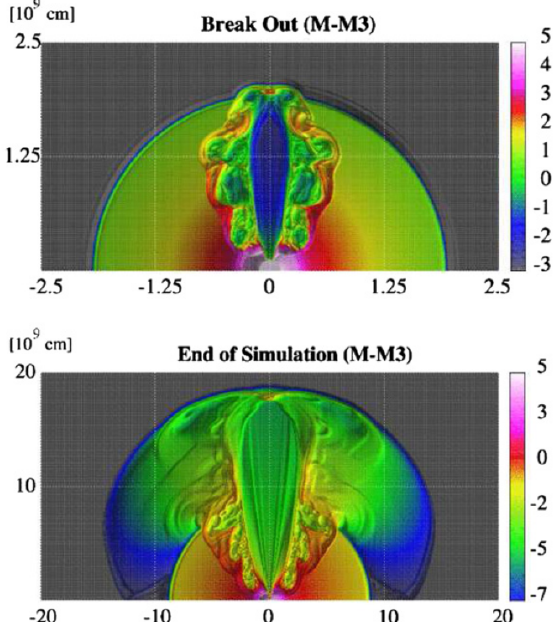
Figure 9. Two snapshots from a model of [192]. The top panel is at the time where the jet breaks out and the lower panel at the end of the simulation. The jet was injected at 50 ms after merger with an opening angle of 15 ◦ . The average opening angle of the jet after break out is 12.6 ◦ . (Reprinted from [192]. c (cid:13) AAS. Reproduced with